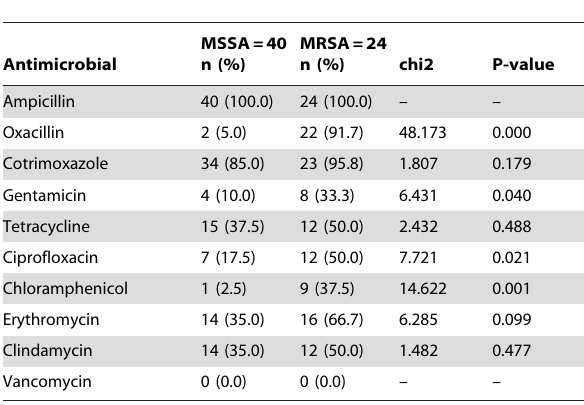
Table 1. Comparison of antimicrobial resistance patterns between MSSA and